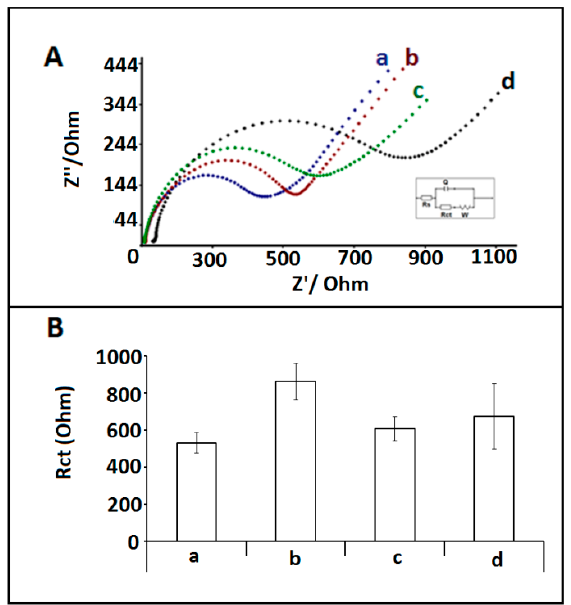
Figure 7. ( A ) Nyquist diagrams representing the R ct values obtained by ( a ) 1 µg/mL miRNA-34a probe modified /IL/CA/PGE in FBS (1:10), hybridization between 1 µg/mL miRNA-34a DNA probe and 10 µg/mL ( b ) miRNA-34a target, ( c ) miRNA-155a, ( d ) miRNA-181b in FBS (1:10). ( B ) Histograms representing the R ct values obtained by ( a ) 1 µg/mL miRNA-34a probe modified /IL/CA/PGE in FBS (1:10), after hybridization between 1 µg/mL miRNA-34a DNA probe and 10 µg/mL ( b ) miRNA-34a target, ( c ) miRNA-155, ( d ) miRNA-181b in FBS (1:10).